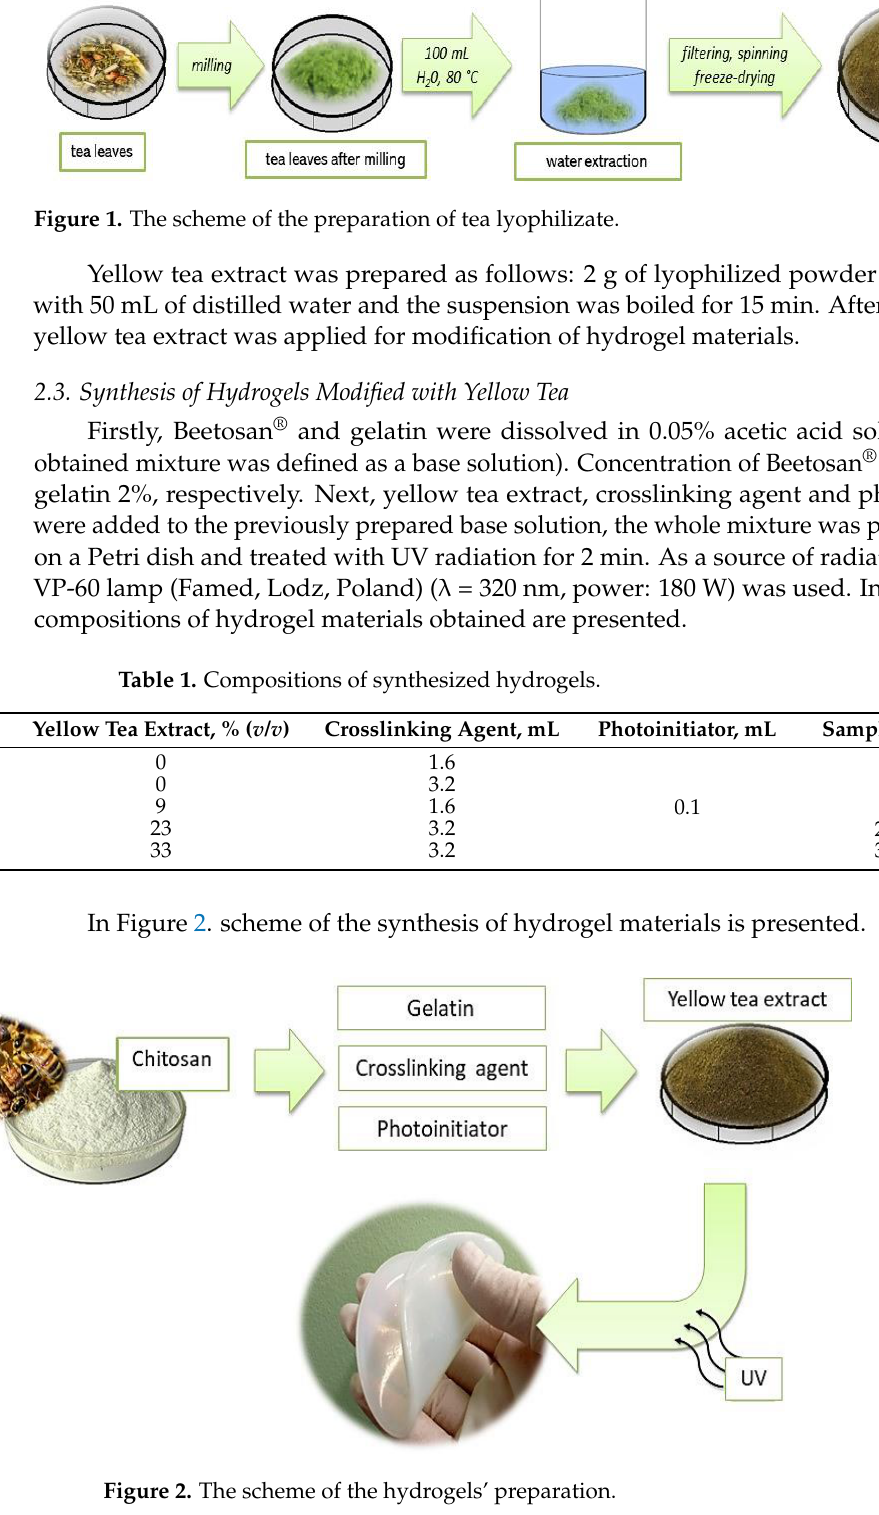
Figure 1. The scheme of the preparation of tea lyophilizate.